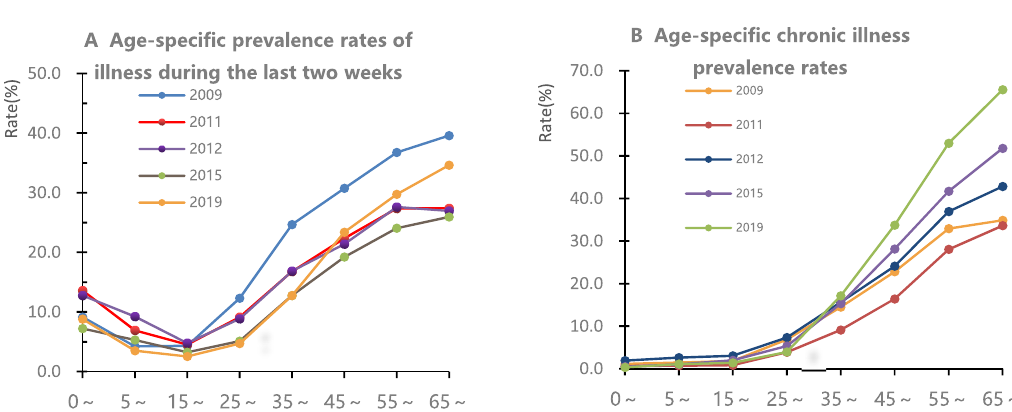
Figure 2. The age-specific prevalence rates of illness during the last 2 weeks and the age-specific chronic illness prevalence rates from 2009 to